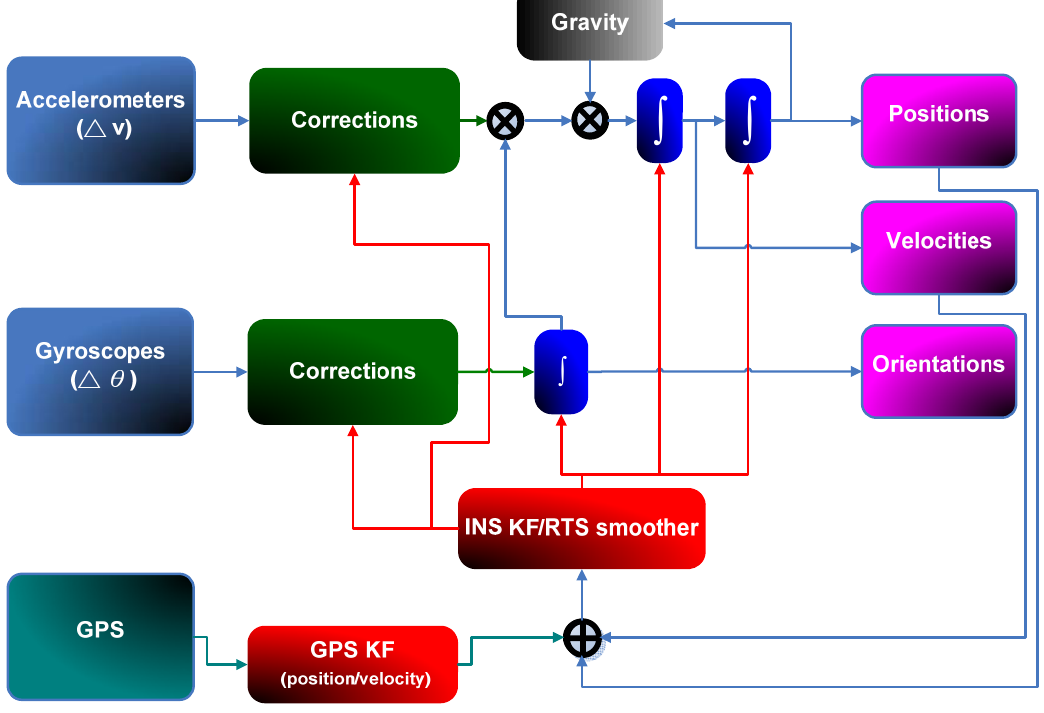
Figure 2. A loosely coupled INS/GPS integration architecture (Closed